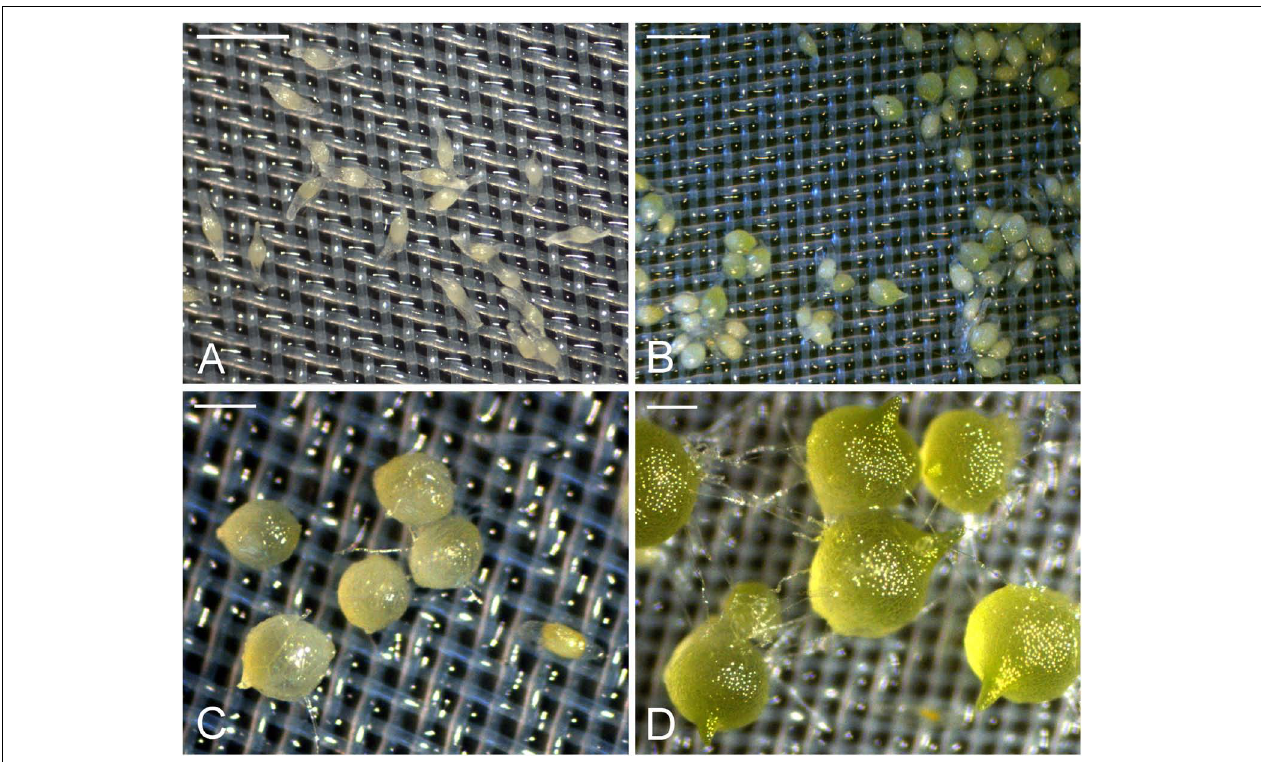
FIGURE 1 | The successive developmental stages of D. officinale from seed germination to protocorm formation in symbiotic culture. (A) Stage 0, the embryos enclosed by the intact seed coats in the first week of inoculation. Scale bar = 0.5 mm. (B) Stage 1, swollen seeds after 1 week of inoculation. Scale bar = 0.5 mm. (C) Stage 2, globular protocorm rupturing the seed coat after 2 weeks of inoculation. Scale bar = 1 mm. (D) Stage3, green protocorm with the shoot tip and rhizoids after 3 weeks of inoculation. Scale bar = 1 mm.